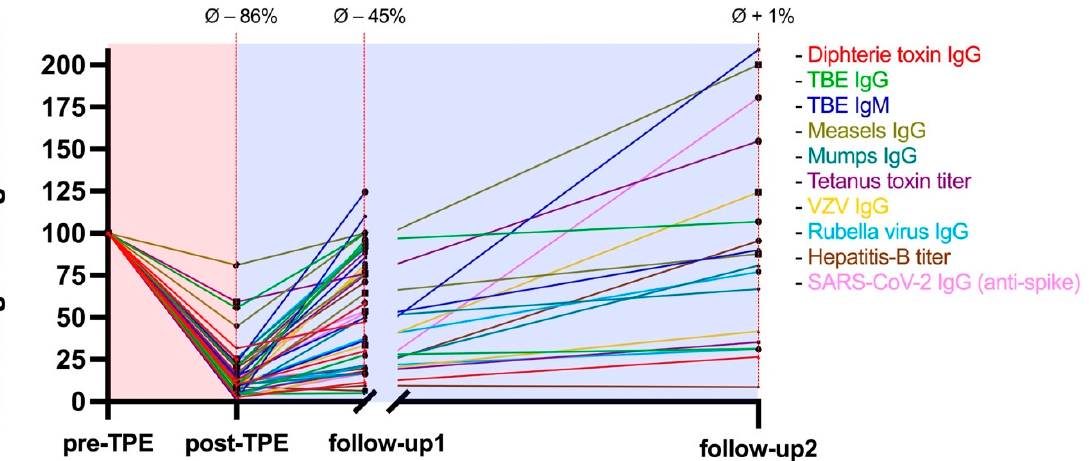
Figure 1. Changes in pathogen-specific antibodies in association with TPE. Antibody levels decreased by − 86% compared to baseline values and recovered to 56% percent of pre-TPE baseline values at follow-up1 and approached baseline values at follow-up2. Follow-up1 and follow-up2 were conducted 5 weeks and 130 days after the last TPE session, respectively. Data from individuals treated with immunosuppressive drugs (anti-CD20 monoclonal antibodies n = 2; azathioprine n = 1) and/or with intravenous immunoglobulins (IVIG; n = 5) after TPE were excluded from the respective follow-ups. One patient was lost to follow-up after TPE. TPE = therapeutic plasma exchange; pre-TPE = prior to therapeutic plasma exchange; post-TPE = immediately after therapeutic plasma exchange; Ø = average change to baseline levels; TBE = tick-borne encephalitis; VZV = varicella zoster virus.